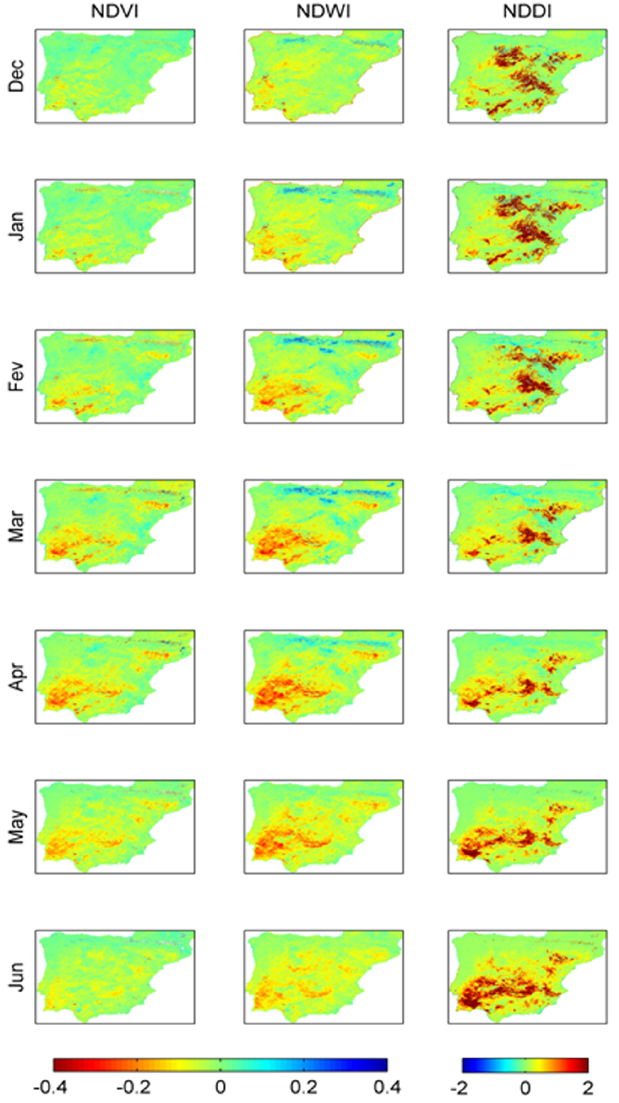
Fig. 3. Monthly NDVI (left panel), NDWI (central panel) and NDDI (right panel) anomalies from December 2004 to June 2005, with respect to the hydrological year of 2004/2005.